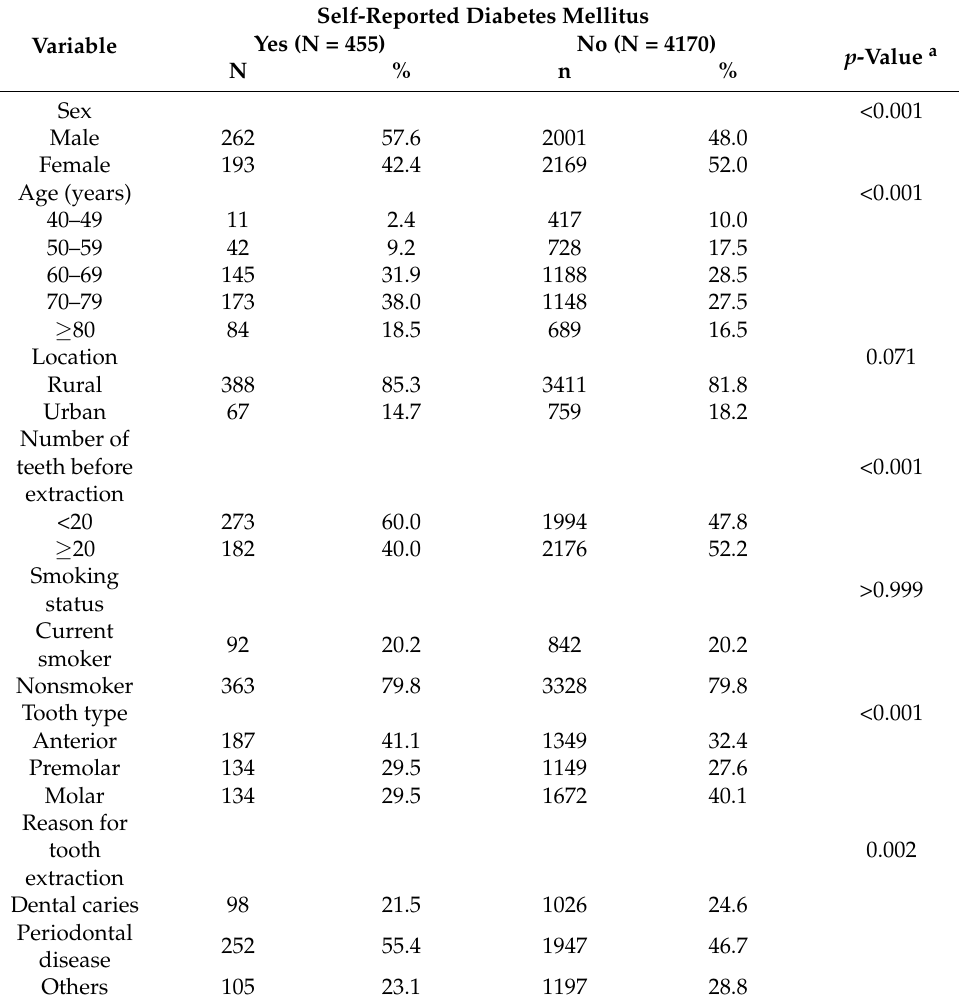
Table 1. Characteristics of the extracted teeth in patients with and without self-reported diabetes mellitus.